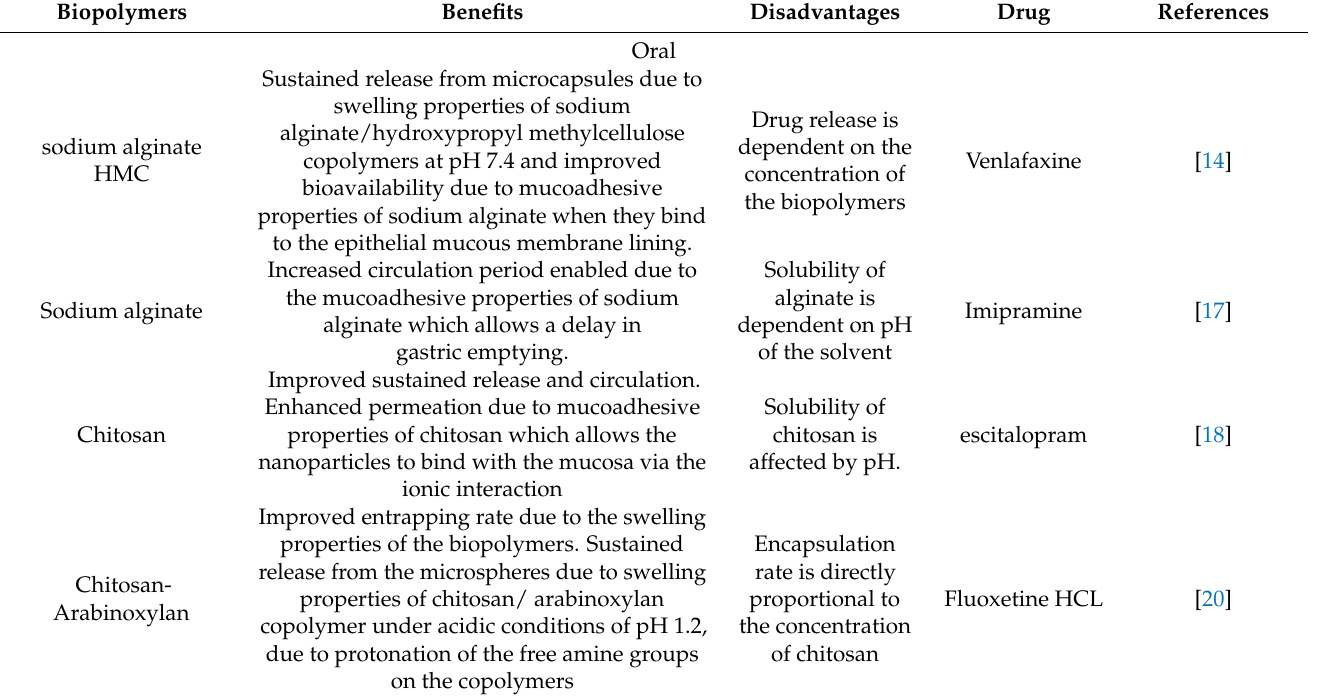
Table 1. Summary of the application of biopolymers using different routes of